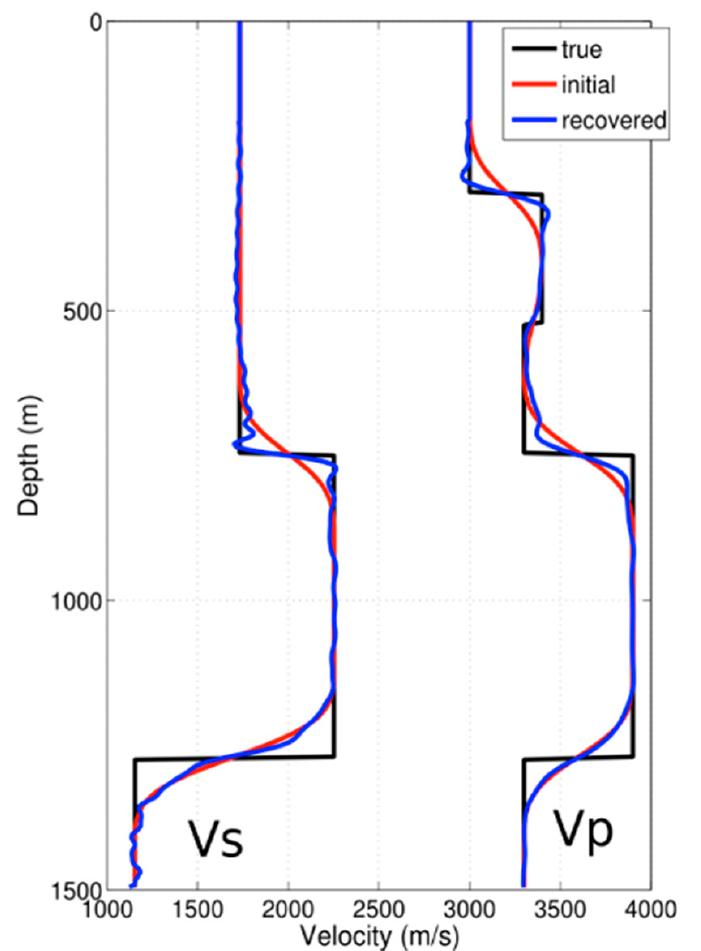
Figure 2. Vertical profiles of the accurate velocity distribution (black) at a distance 1000 m, smooth propagator used for inversion (red) and the reconstructed full velocity model after minimisation concerning data ‐ space reflectivity (blue) .